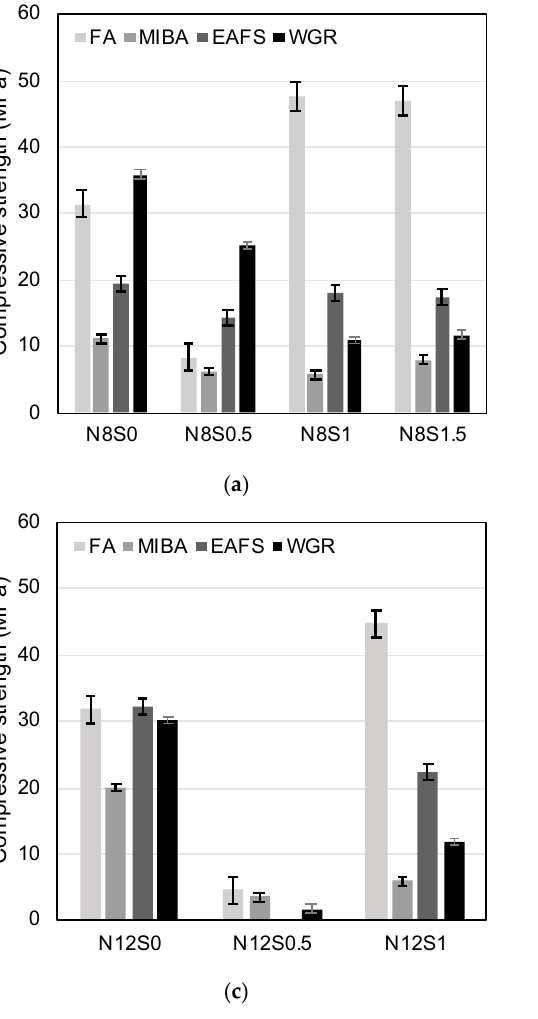
Figure 7. Compressive strength values for mixes with FA, MIBA, EAFS, and WGR with Na 2 O/binder ratios of ( a ) 8%, ( b ) 10%, ( c ) 12%, and ( d ) 14%, respectively. Although the best performance was generally attained by specimens with higher Na 2 O content, the opposite was seen in WGR-containing mixes; the corresponding N14S0 mix showed a low value of ~9.5 MPa, whereas those with FA, MIBA, and EAFS presented values of ~32 MPa, ~18 MPa and ~37 MPa, respectively. The concentration of Na + was much higher (both from the activator as well as the precursor itself) than needed for the WGR N14S0 mix, where notable efflorescence was noticed (Figure 8). This phenomenon occurs when the Na + ions migrate to the surface of the specimens, resulting in the precipitation of sodium carbonates [36]. The high concentrations of sodium hydroxide and sodium silicate are known to affect the development of compressive strength of alkali- activated mixes [36,86]. Vafaei and Allahverdi [87] investigated the tendency of alkali- activated waste glass powder towards efflorescence formation. The study concluded that the tendency is dependent on the concentration of free alkali in the cured alkali-activated concrete specimens. The high free-alkali concentration increases the tendency of alkali to migrate to the surface of the sample, consequently forming efflorescence caused by the weak binding of Na + ions [88].